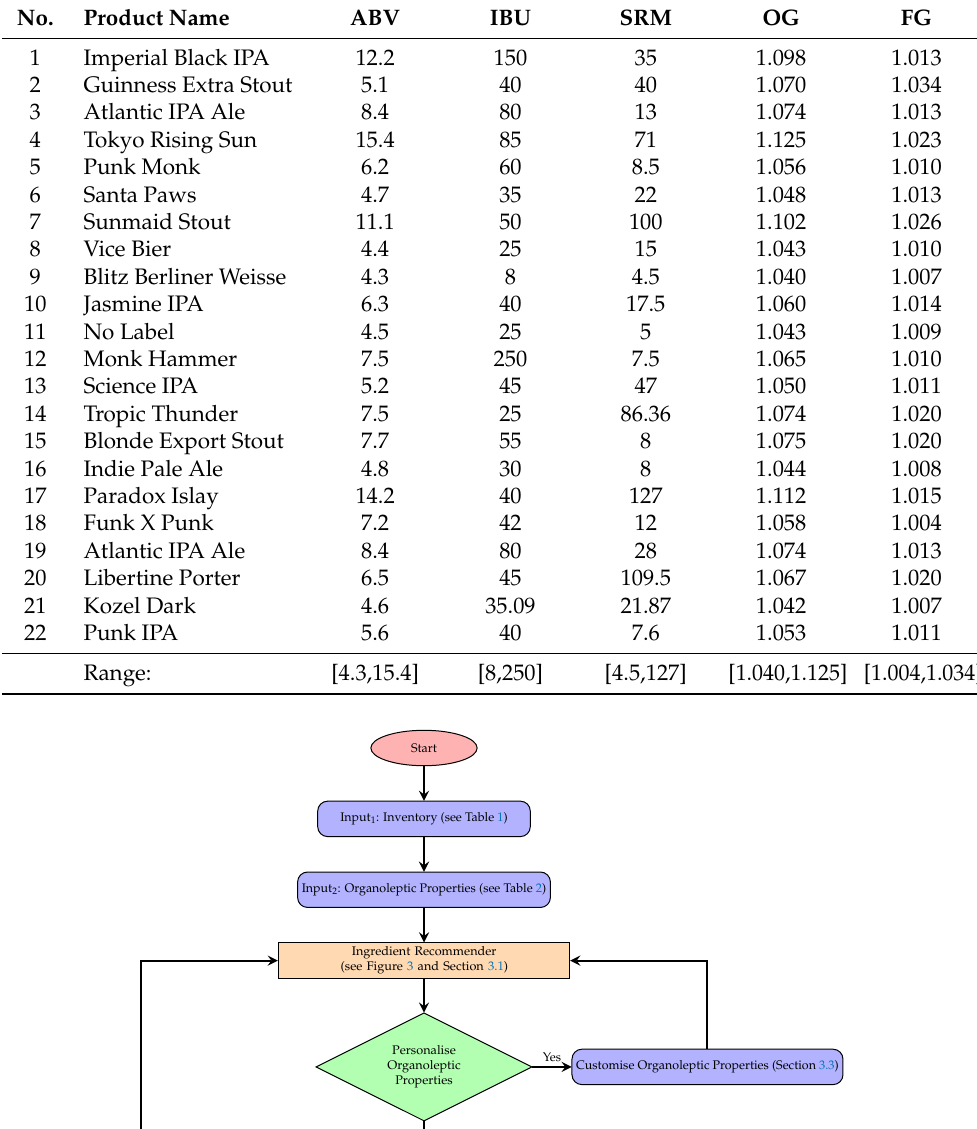
Table 2. Beer characteristics in a diverse set of products.